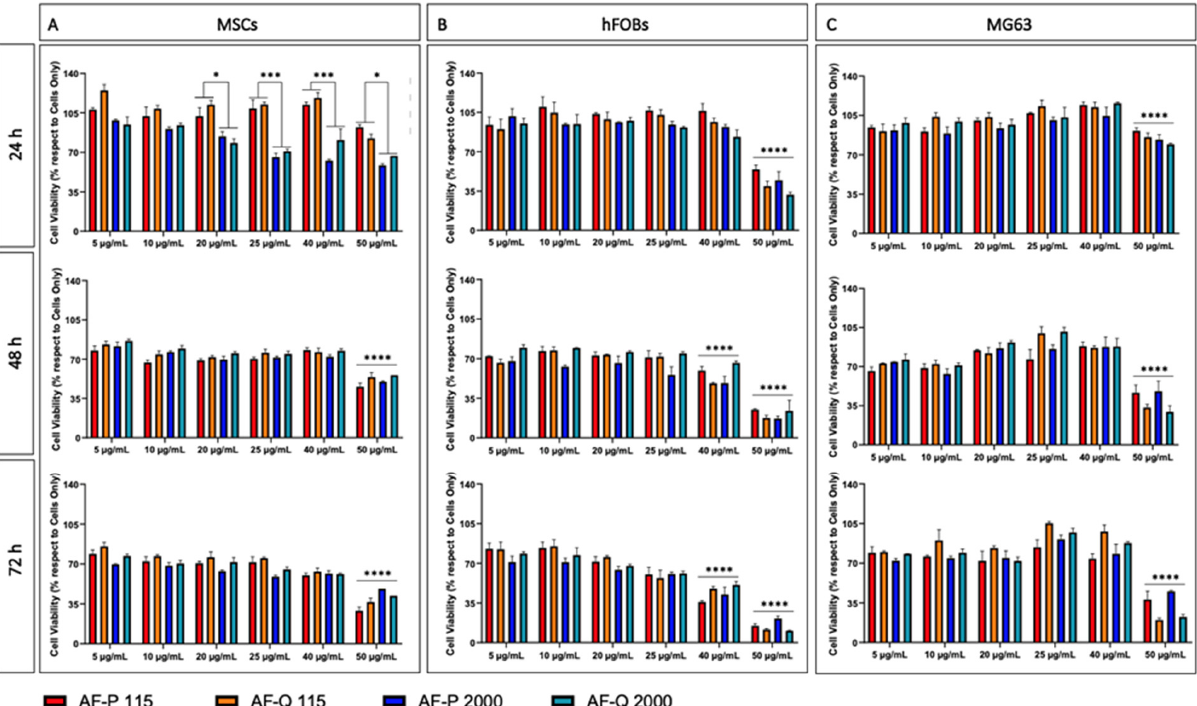
Figure 6. Cell viability analysis. MTT assay was performed after 24 h, 48 h and 72 h of being in the culture. MSCs ( a ), hFOBs ( b ) and MG63 ( c ) were cultured in contact with 5 concentrations of AF-P/lDNA 115, AF-Q/lDNA 115, AF-P/lDNA 2000 and AF-Q/lDNA 2000 (5 µg.mL − 1 ; 10 µg.mL − 1 ; 20 µg.mL − 1 ; 25 µg.mL − 1 ; 40 µg.mL − 1 ; 50 µg.mL − 1 ) at N/P of 8. The data show the percentage of viable cells as compared to cells only as the control, and the mean ± SEM are presented. * p value < 0.05, *** p value < 0.001, **** p value < 0.0001.